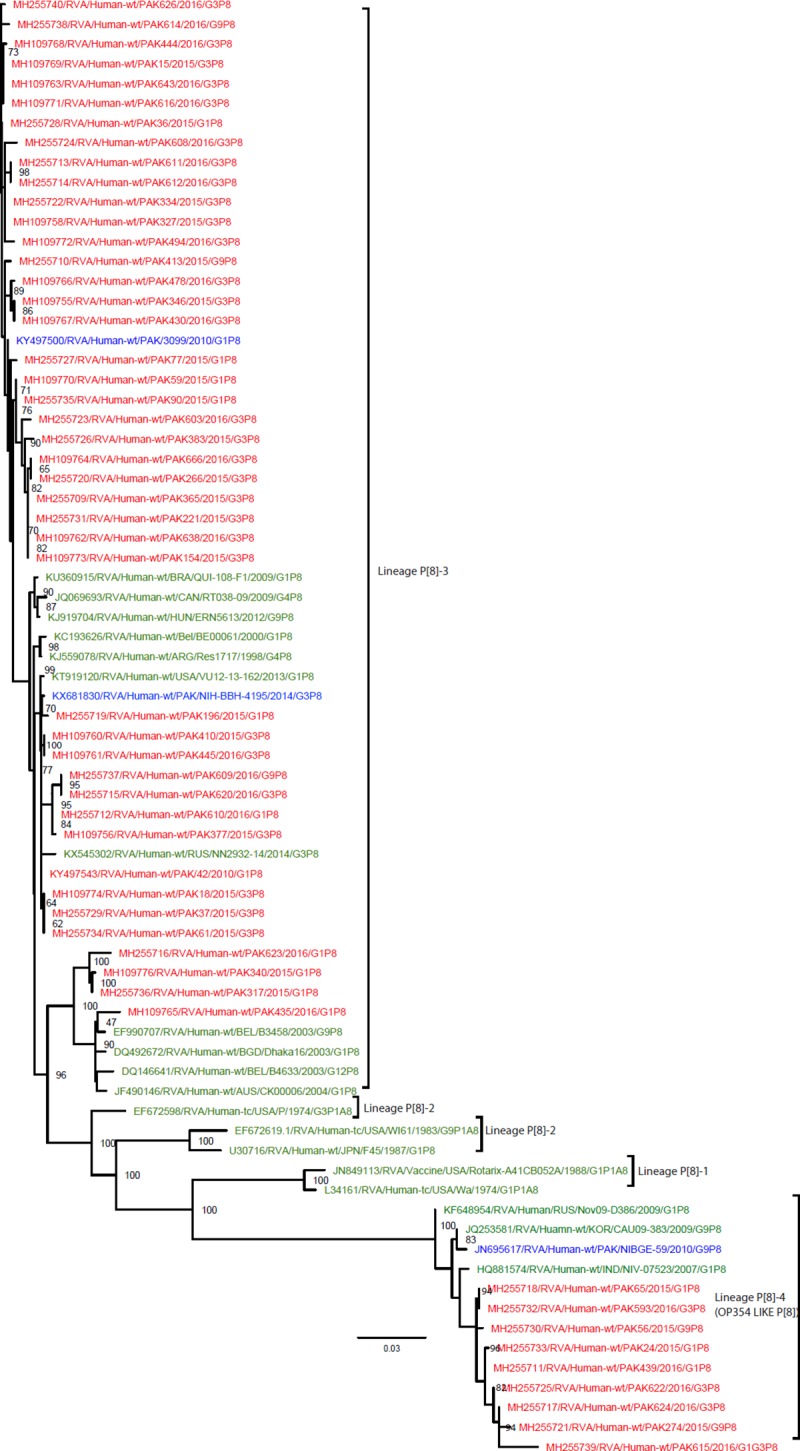
Maximum likelihood phylogenetic tree constructed from the nucleotide sequences of P[8]-VP4 strains and representative RVA strains with kimura-2-parameter model in MEGA program 6.0.Bootstrap values <60 are not shown. RVA strains sequenced in this study are represented by the red colour. Pakistani Strains reported in the previous studies are shown in blue. The out group strain is represented by purple colour while green shading represent strains isolated in all over the world. The RVA strains sequenced in this study and reference strains obtained from Genbank data library are represented by Accession number, Strain Name, Country and year of Isolation. Scale bar: 0.03 substitutions per nucleotide.